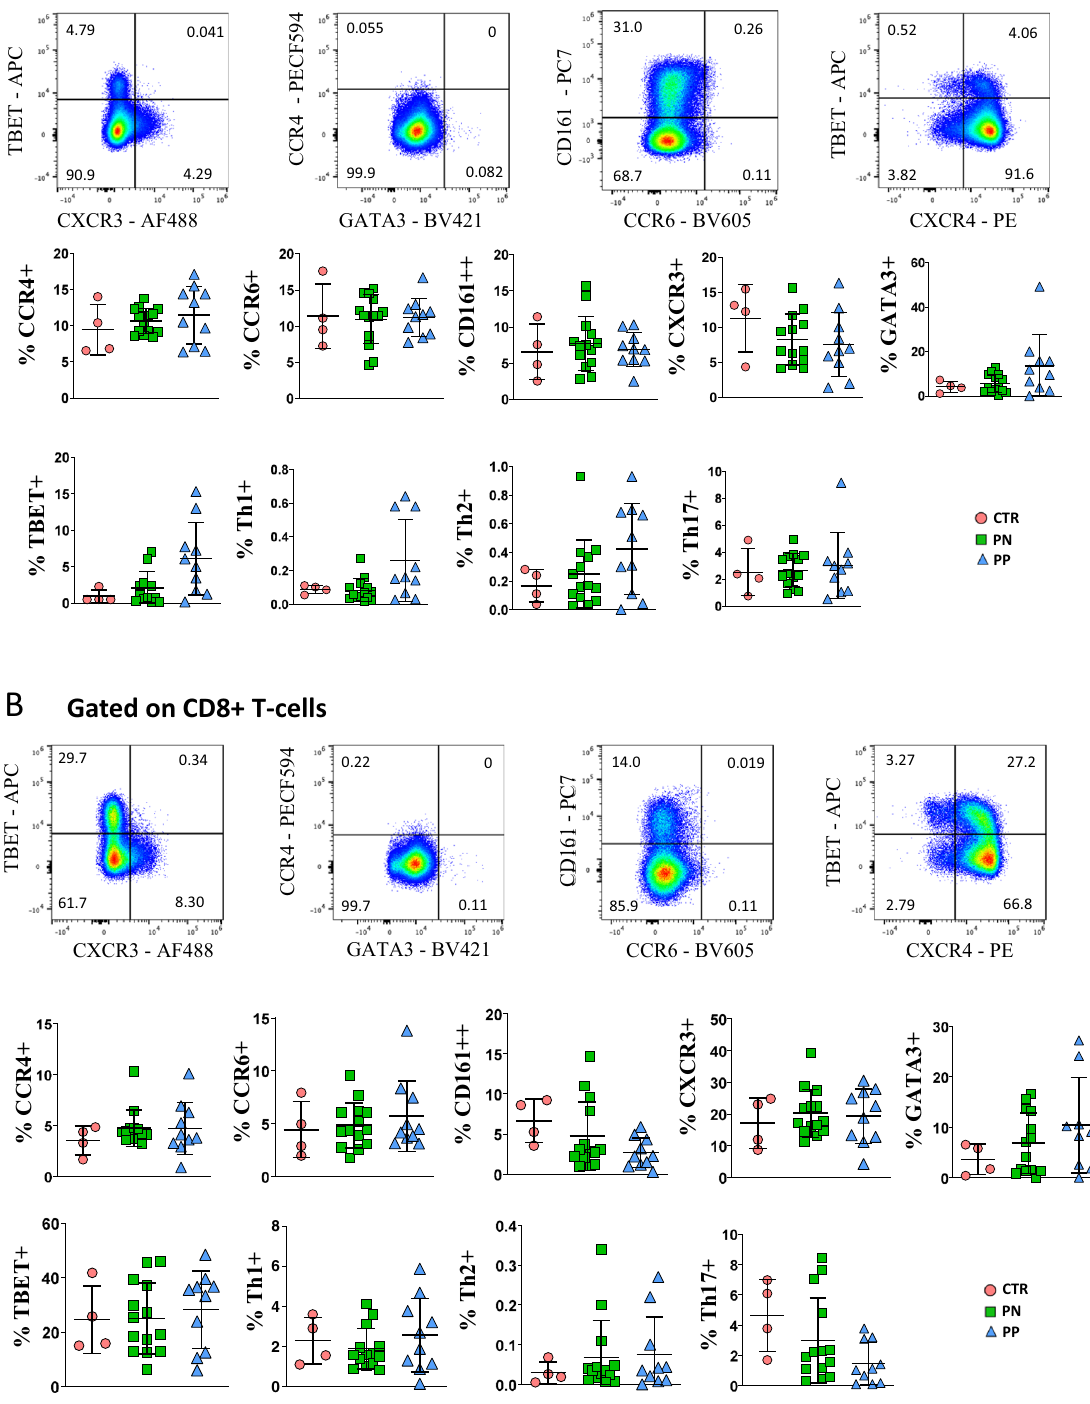
Fig. 6 Phenotypic characterization of CD4 and CD8 T cells of COVID-19 pregnant women. A Expression of different chemokine receptors and lineage- specifying transcription factors in gated CD4 + T cells from healthy donors (CTR, n = 4), pregnant negative (PN, n = 13) and pregnant positive (PP, n = 10). Values (dots) for the three conditions are matched with the color used in Figs. 1 – 5. Data represent individual percentage values (dots), mean (center bar), and SD (upper and lower bars). Two-tailed Mann – Whitney t -test with Bonferroni correction has been used. Exact p -value is indicated in the fi gure, if signi fi cant. B Expression of different chemokine receptors and lineage-specifying transcription factors in gated CD8 + T cells from healthy donors (CTR, n = 4), pregnant negative (PN, n = 13) and pregnant positive (PP, n = 10). Values (dots) for the three conditions are matched with the color used in Figs. 1 – 5. Data represent individual percentage values (dots), mean (center bar) and SD (upper and lower bars). Two-tailed Mann – Whitney U -test with Bonferroni correction has been used. The exact p -value is indicated in the fi gure, if signi fi